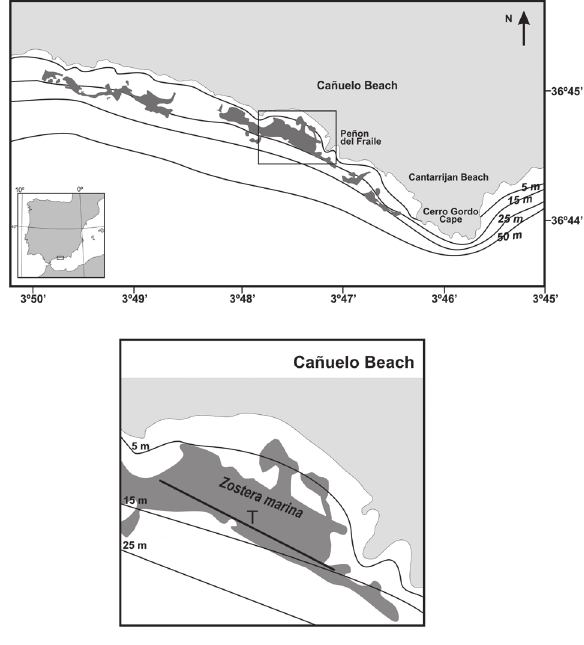
Fig . 1. – study area. “El Cañuelo” beach on the Malaga coast (Mediterranean sea, spain). T: trawl transect. n: north.